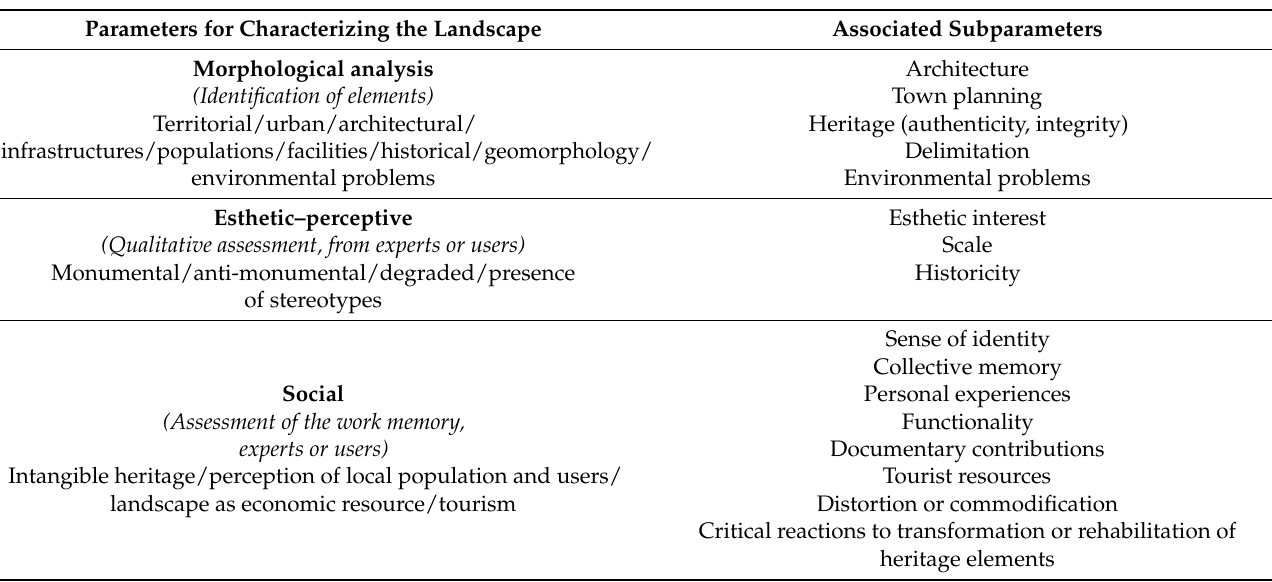
Table 1. Landscape characterization of sampling #2.